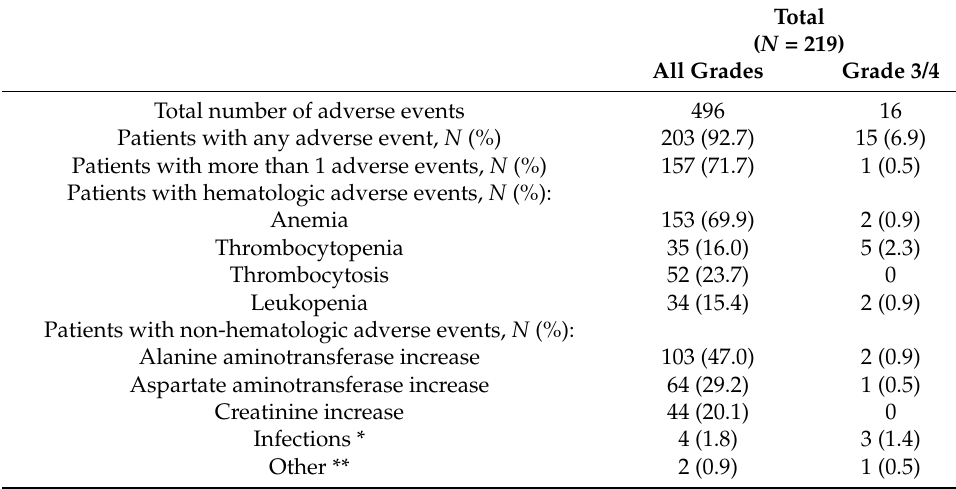
Table 4. Adverse events in the safety population of patients treated with ruxolitinib for